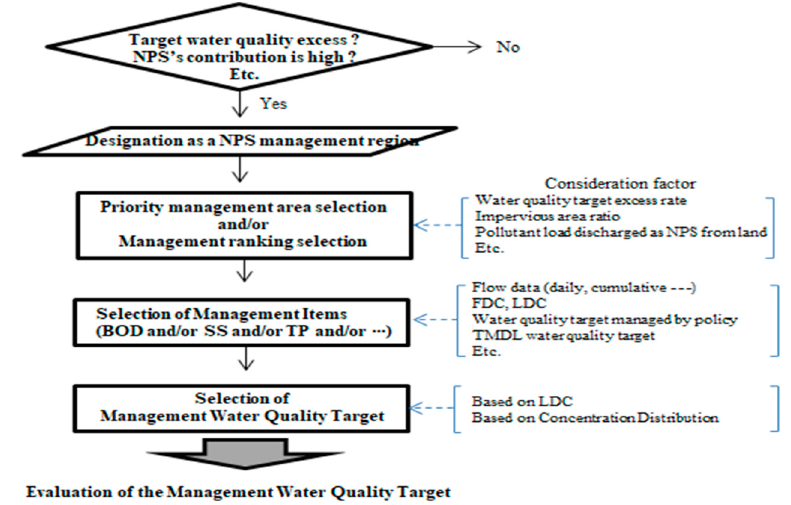
Figure 1. Flowchart of the whole method.